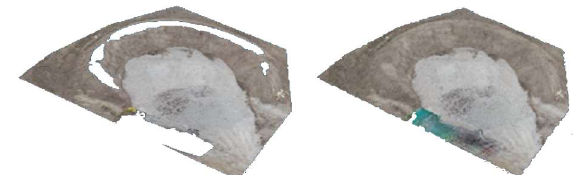
Figure 13: The gaps of the point cloud (left) are filled in the mesh (right) by interpolating the triangles over the gaps.